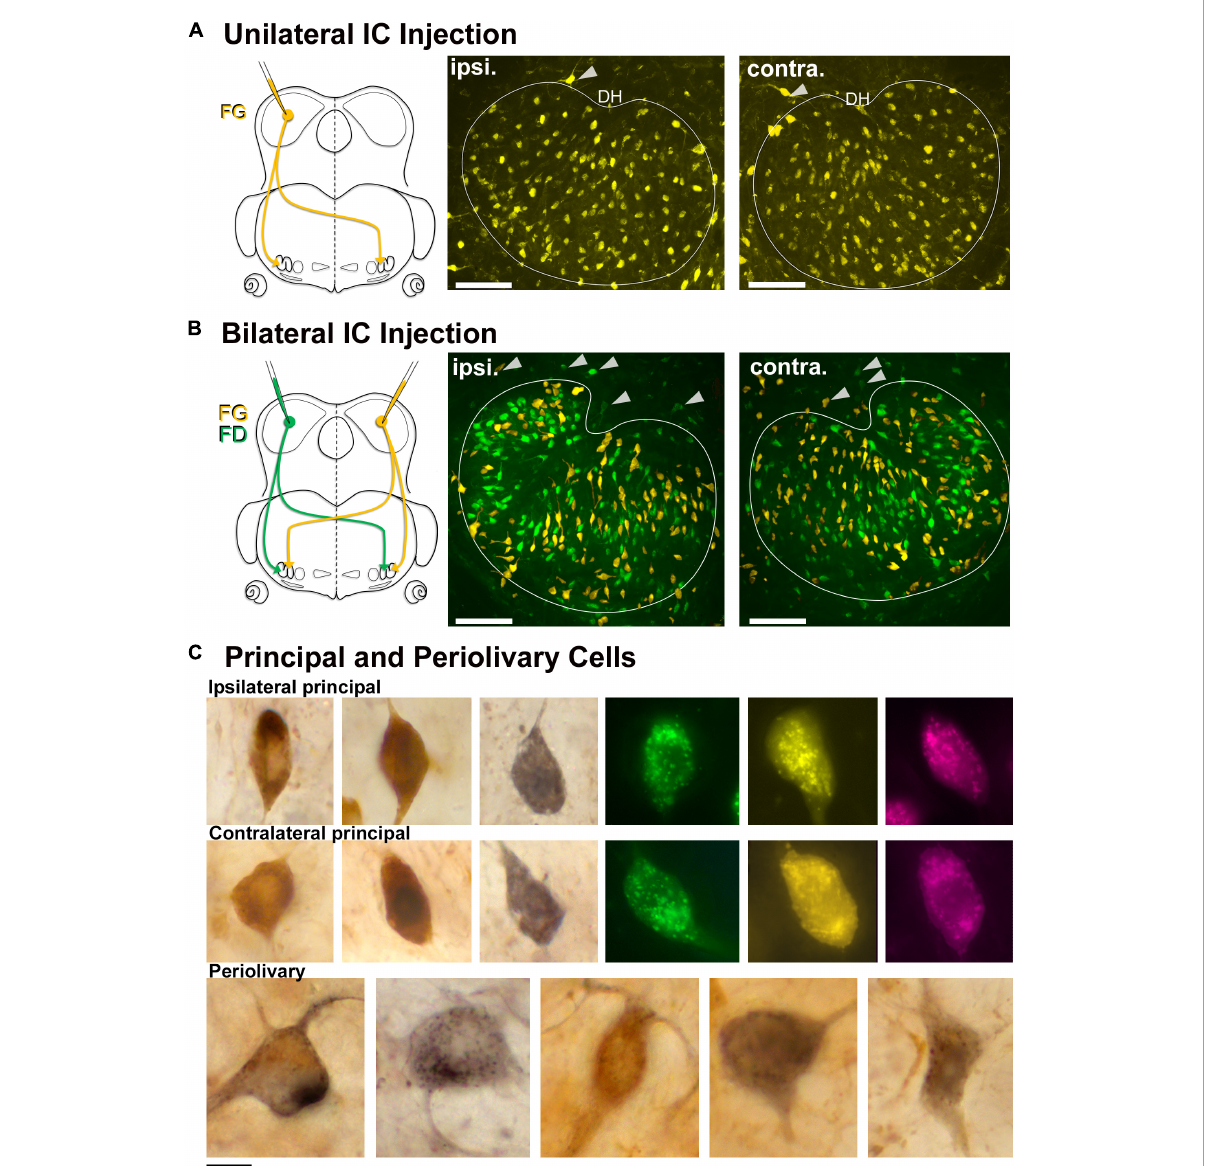
FIGURE1 Retrogradely labeled LSO principal neurons from unilateral and bilateral tracer injections into the CNIC. (A) A unilateral injection of a retrograde tracer into the CNIC resulted in bilateral labeling of LSO principal neurons. Schematic representation of FluoroGold (FG) injected into the CNIC to label the neurons in the LSO with ascending projections. Photomicrographs (20x objective) of the ipsilateral and contralateral LSO showing FG-labeled principal neurons. Gray arrowheads: PO neurons on the borders of the LSO. (B) Schematic illustration of the retrograde tracers FG (yellow) and FD (green) injected into the right and left IC, respectively (same animal), to label the principal neurons in the LSO. Photomicrographs (20x objective) of the ipsilateral and contralateral LSO showing FG and FD labeled principal neurons in the same nucleus. Gray arrowheads: PO neurons on the borders of the LSO. (C) Photomicrographs (100x objective) of the ipsilateral (top row) and contralateral (middle row) principal cells labeled from chromogenic development of FG with DAB (brown) or NiDAB (black) and fluorescent tracers (FD-green, FG-yellow, Antionia Red-magenta). The principal neurons were fusiform with unipolar or bipolar dendritic extensions. The preolivary neurons were also labeled (bottom row) and featured a large, polygonal cell body using chromogenic development. ipsi., ipsilateral; contra., contralateral; FG, fluorogold; FD, fluorescein dextran. Scale bar equals 100 µ m (A,B) , 25 µ m (C) .